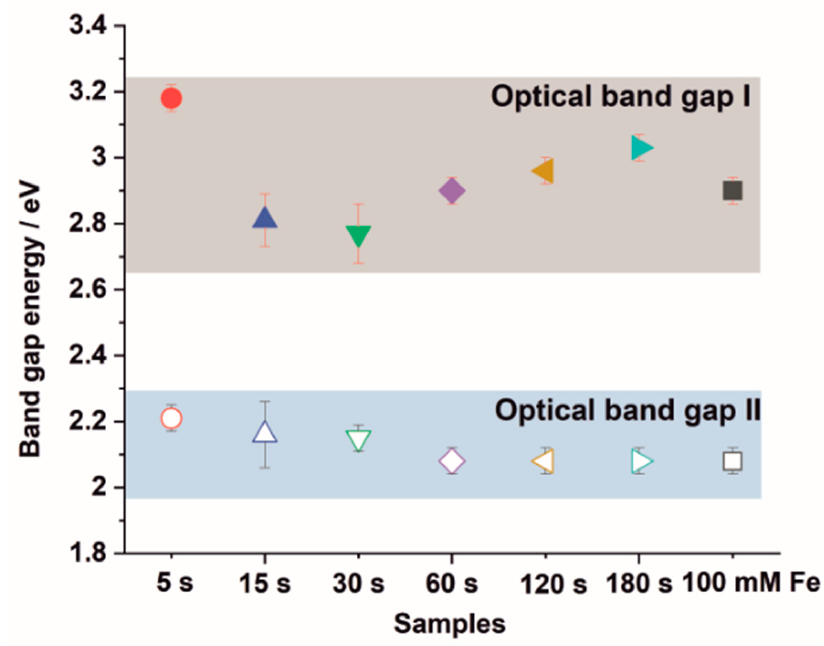
Figure 5. Band gap energies estimated from UV–Vis DRS measurements for all tested Fe 2 O 3 –TiO 2 materials.